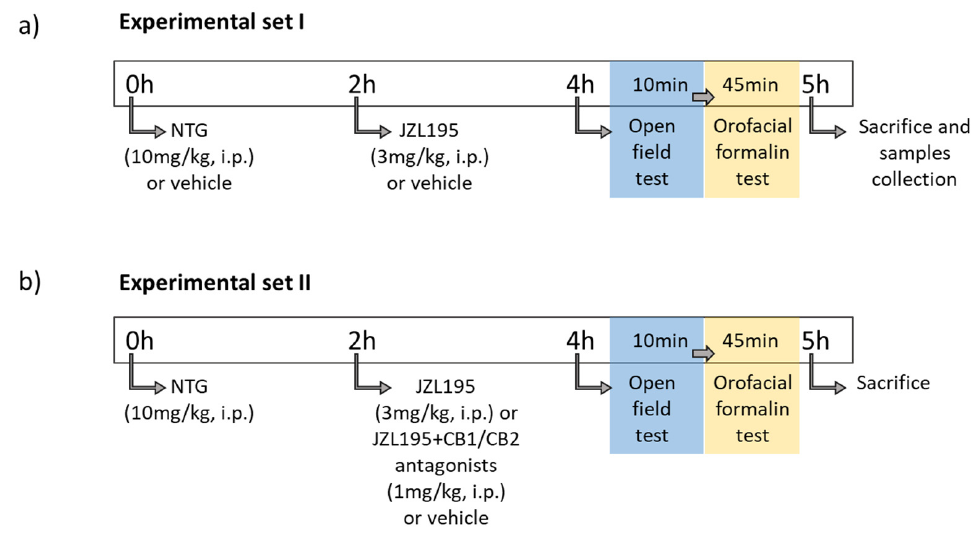
Figure 1. Experimental timeline for the treatment and testing procedures. ( a ) In the first experimental set, JZL195 (or its vehicle) was administered 2 h after NTG (or its vehicle) and 2 h before the open field test (of 10 min duration); immediately after the open field, rats were injected with formalin (50 µ L, s.c.) and the orofacial formalin test was performed (45 min duration). At the end of the test, rats were sacrificed by decapitation and samples collected for ex vivo analysis. ( b ) The second experimental set was achieved to evaluate CB1 and CB2 involvement: JZL195 was administered in combination with AM251 (CB1 antagonist, 1 mg/kg, i.p.) or AM630 (CB2 antagonist, 1 mg/kg, i.p.) 2 h after NTG and 2 h before the behavioral tests.